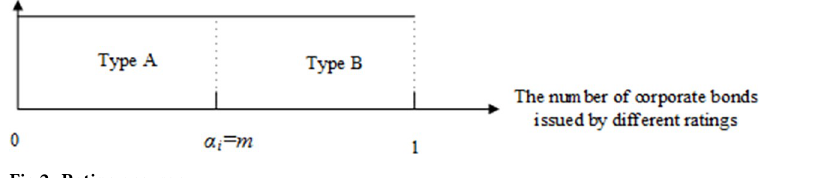
Fig 2. Rating accuracy.